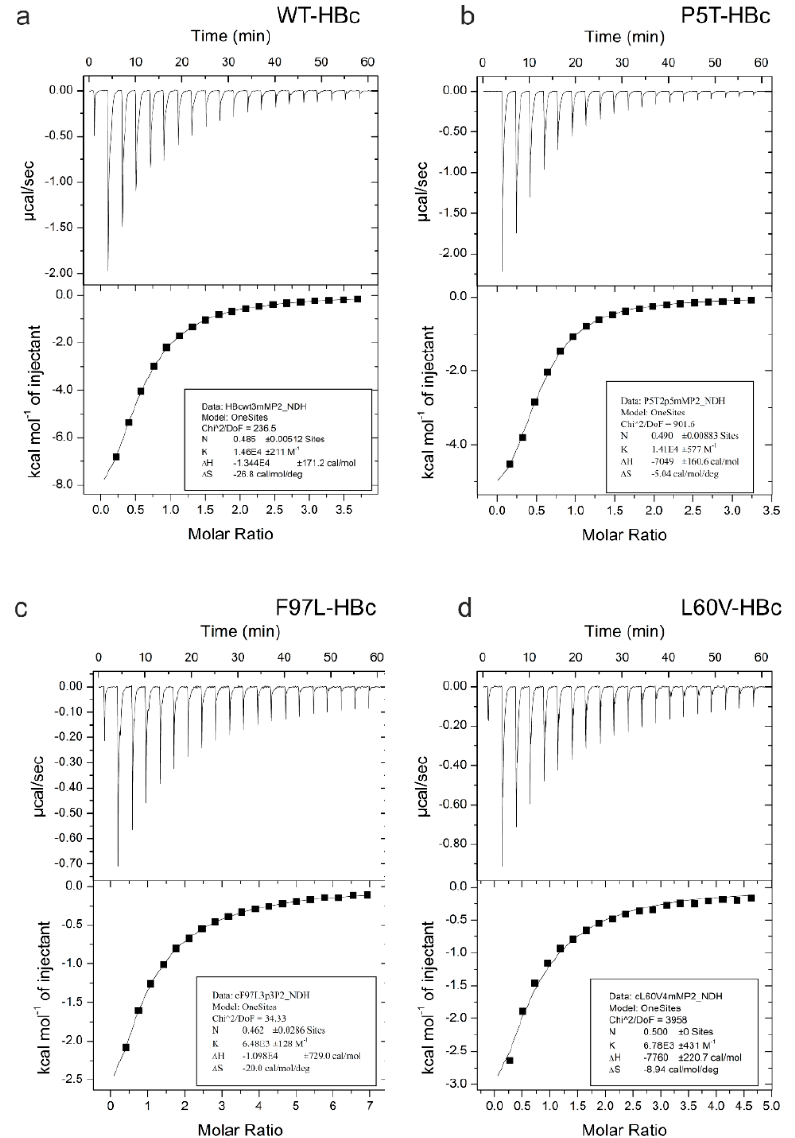
Figure 2. ITC of WT-HBc ( a ), P5T-HBc ( b ), F97L-HBc ( c ) and L60V-HBc ( d ). The plots ( a – d ) show a characteristic titration experiment between capsids of HBc variants in the cell and peptide P2 in the syringe. The upper panel shows the raw ITC isotherms in power versus time. Each peak corresponds to an injection of P2. The area under each peak is proportional to the heat produced at each injection. The lower binding curve shows the total heat developed per mol P2 in dependence on the molar ratio of P2/HBc monomer . The fitted binding curve is shown as a solid line. The fitting results for a single-binding site model are listed in the insert. The fitted parameters were n, ∆ H and K A = 1/K D in panels ( a – c ) and ∆ H and K A = 1/K D with a fixed n = 0.5 in panel ( d ).